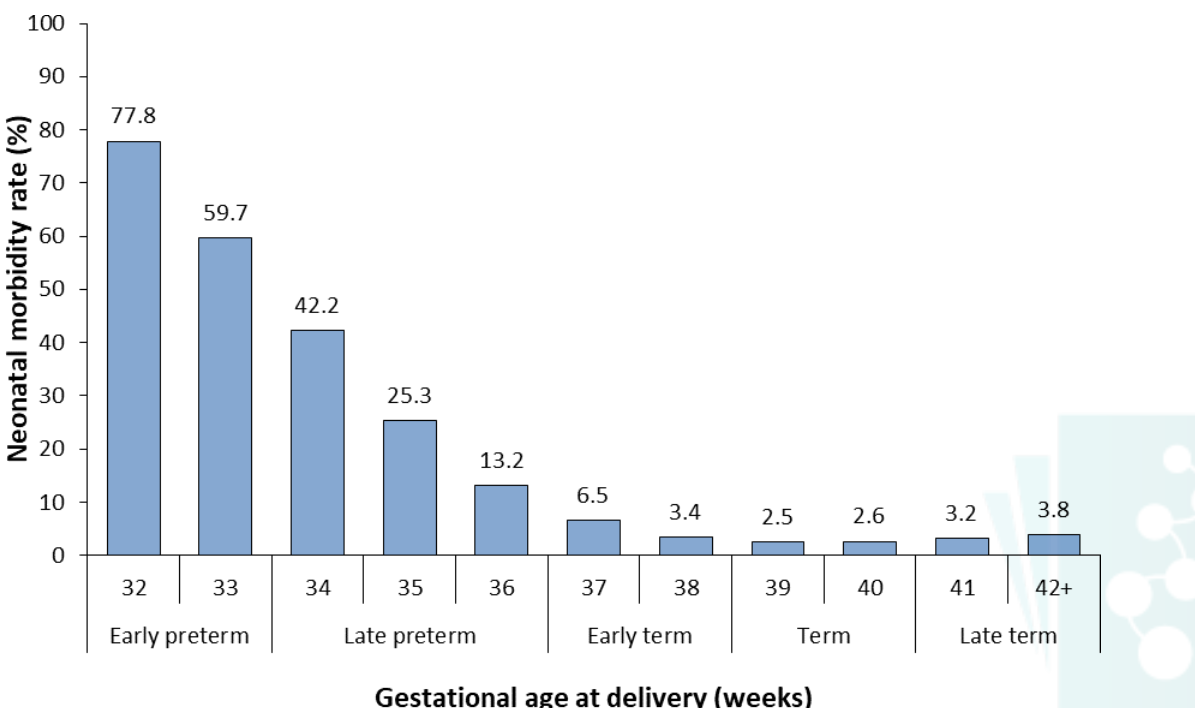
Figure 1: Rate of neonatal morbidity by gestational age at birth, from 32 weeks onwards. All infants of gestational ages <32 weeks are considered to have morbidity as defined by the neonatal adverse outcome indicator